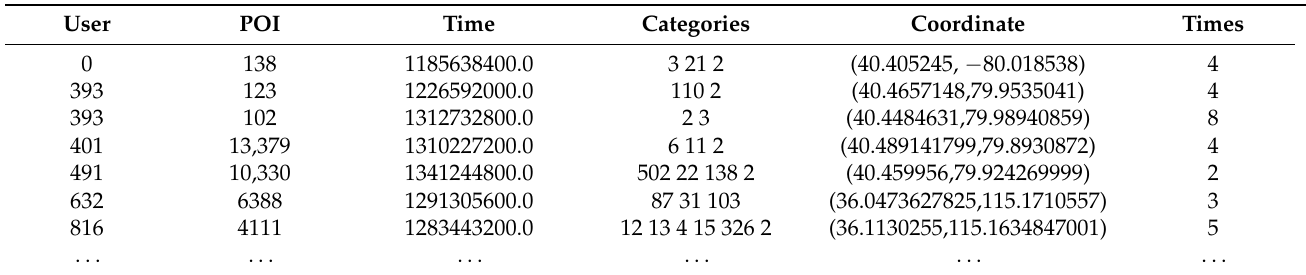
Table 2. Some data of Yelp.